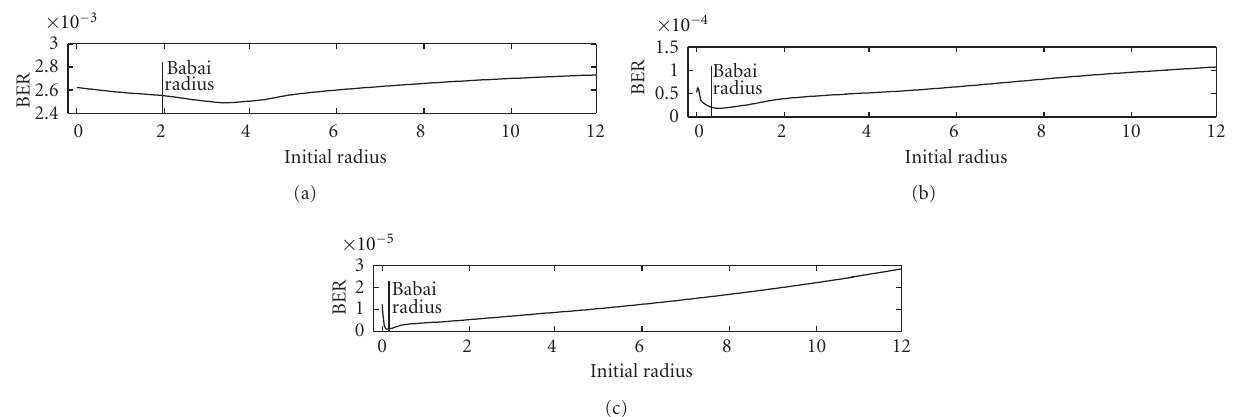
Figure 2: BER versus initial radius of SE-SD algorithm when P = 4, M = 64. (a) ρ = 18 . 4dB, (b) ρ = 21 . 46dB, (c) ρ = 24dB.